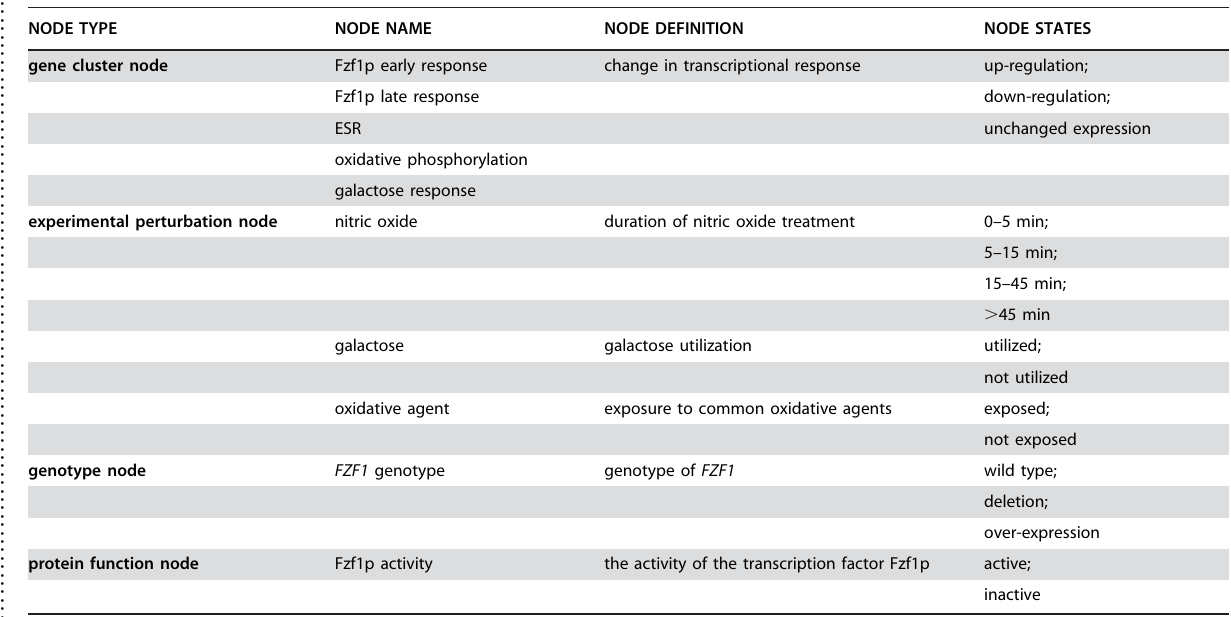
Table 1. Network nodes defined in the initial nitric oxide response model. .. ... .... ... ... .... ... ... .... ... ... .... ... ... .... ... ... .... ... ... .... ... ... .... ... ... .... ... ... .... ... ... .... ... ... .... ... ... .... ... ... .... ... ... .